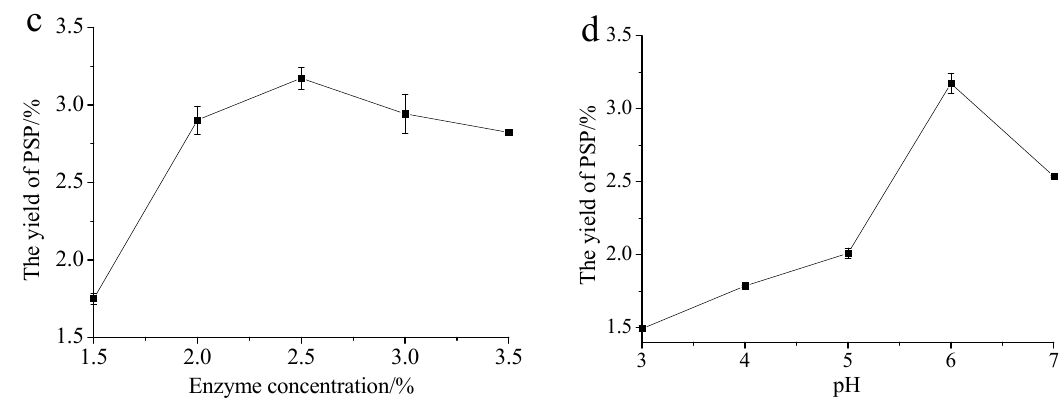
Figure 1. Effect of different experimental variables on the yield of PSP. ( a ) Extraction time; ( b ) Extraction temperature; ( c ) Enzyme concentration; ( d ) pH.